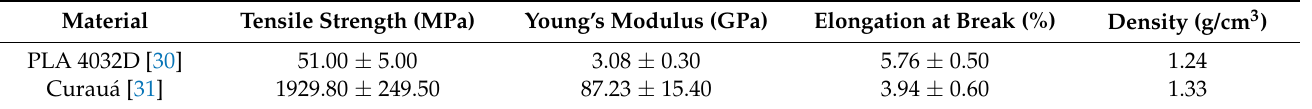
Table 1. Material